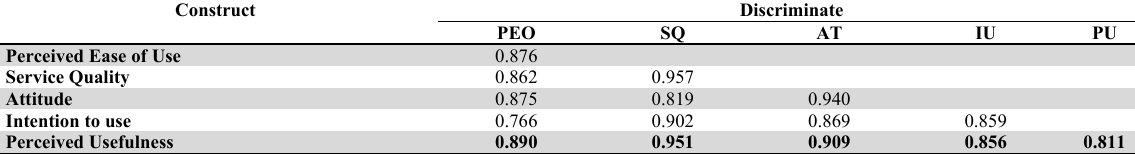
Discriminate validity of Large broadband ISPs Construct